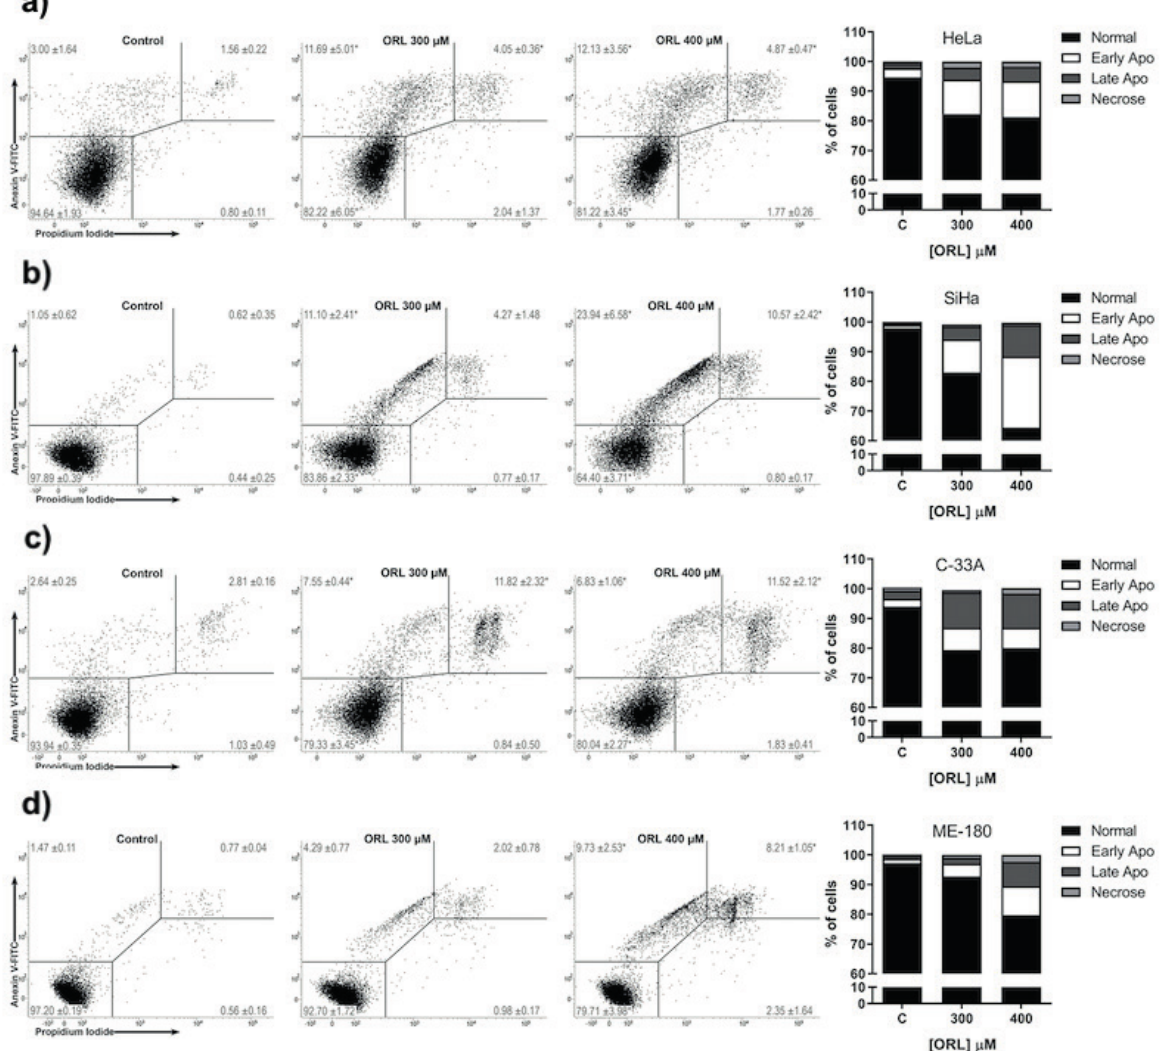
Figure 5. FASN inhibitor (orlistat - ORL) triggers apoptosis in cervical cancer cell lines. Annexin V and propidium iodide (PI) experiments revealed that ORL induces apoptotic cell death but not necrosis in HeLa (a), SiHa (b), C-33A (c) and ME-180 (d) cell lines. Values refer to the average percentage of cells in each gate for three independent experiments ± standard deviation (SD). *p < 0.05 compared to control (one-way ANOVA followed by Tukey’s